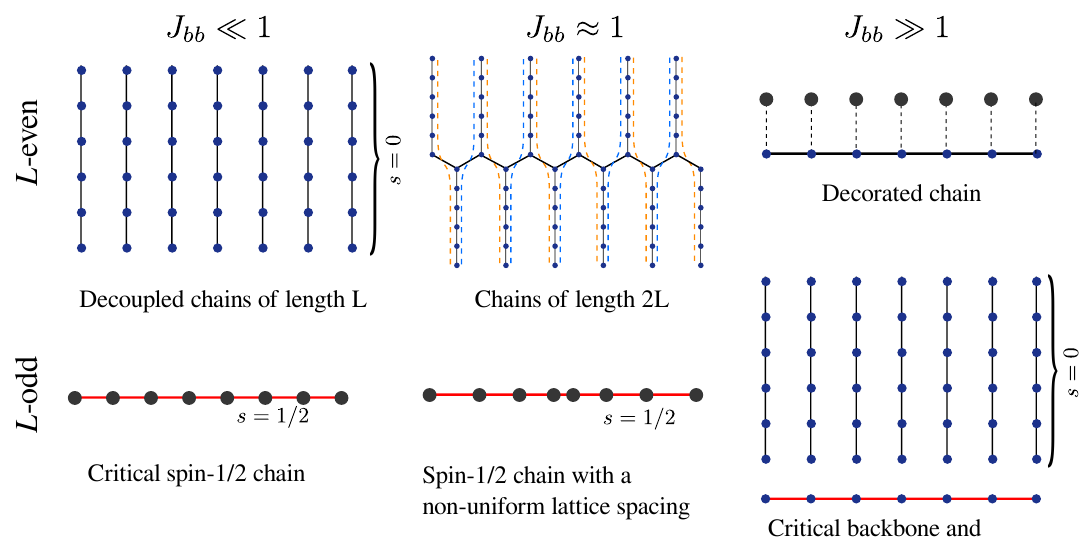
Figure 18: (Color online) Summary of the main critical regimes as a function back- bone interaction and total number of spins per tooth. Non-uniform lattice spacing for L -odd is equivalent to the non-uniform coupling constant J